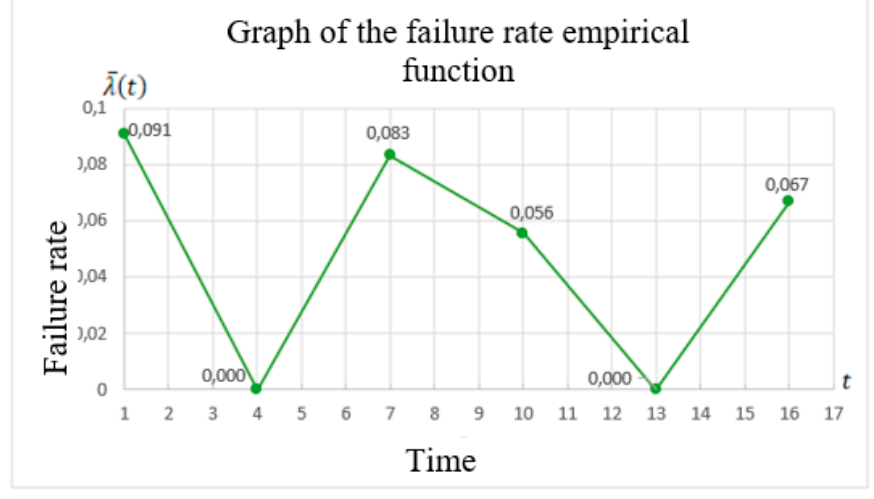
Figure 9. Failure rate function waveform.